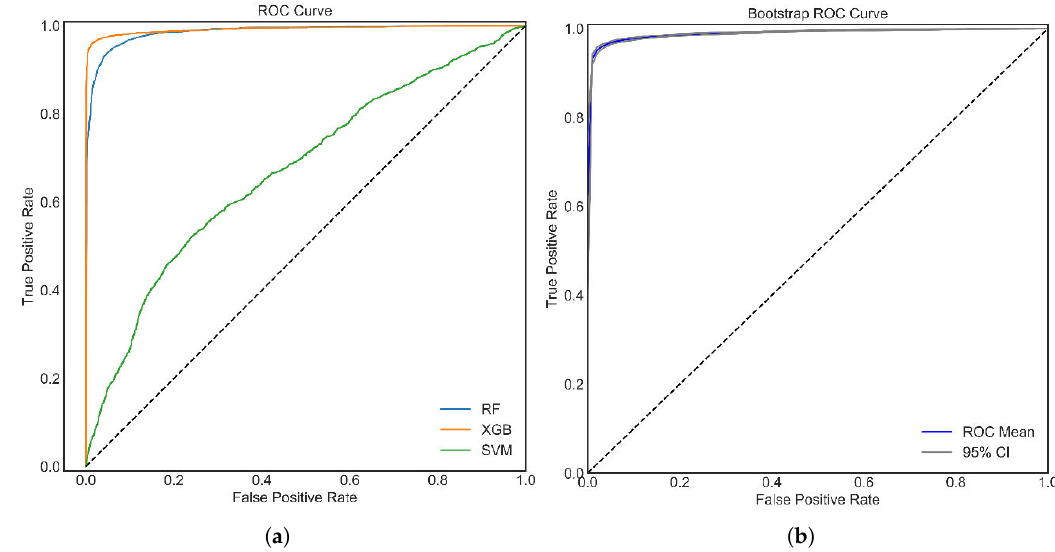
Figure 5. ( a ) ROC of RF, XGB, and SVM; and ( b ) bootstrap ROC analysis of XGB. The XGB classifier outperformed all the other algorithms.